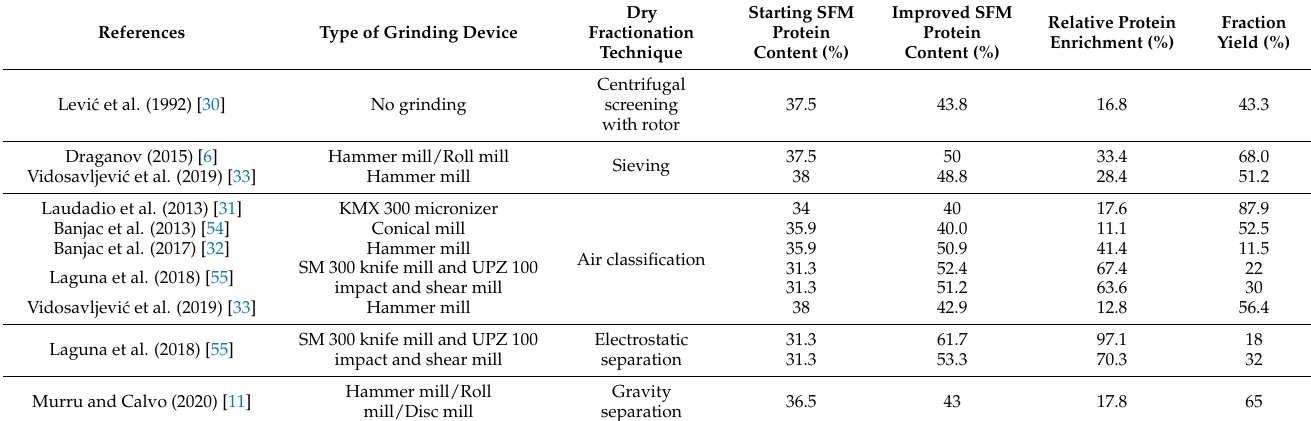
Table 5. Published work related to dry fractionation of SFM and highlighted